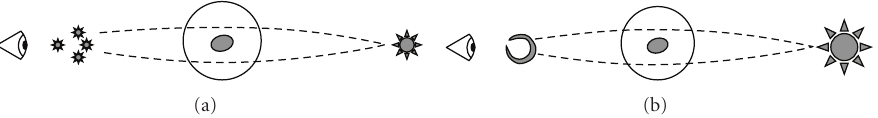
Figure 3: Small and large sources. (a) A galaxy surrounded by a dark matter halo produces multiple images of a small background light source (e.g., an optical quasar). (b) For a larger background source (e.g., a galaxy or a radio-loud quasar), the macroimages may be stretched into arcs or even a complete Einstein